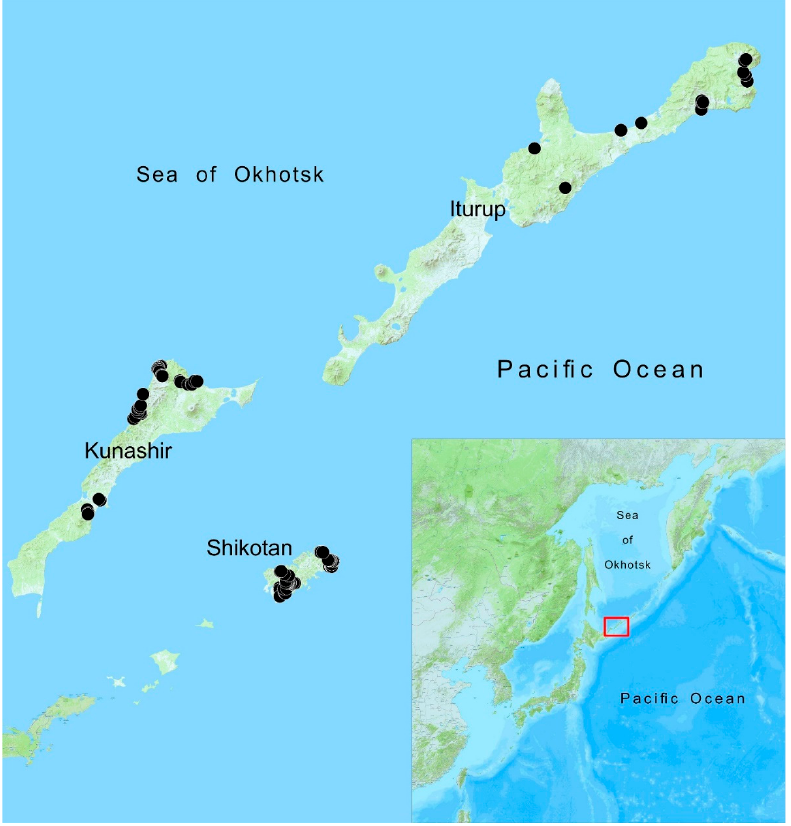
Figure 4. Collection localities by author team in the South Kurils in 2015–2020 corresponding to Table 3. Map with marked locality numbers is provided in Figure S1. Table 3. The collection localities.